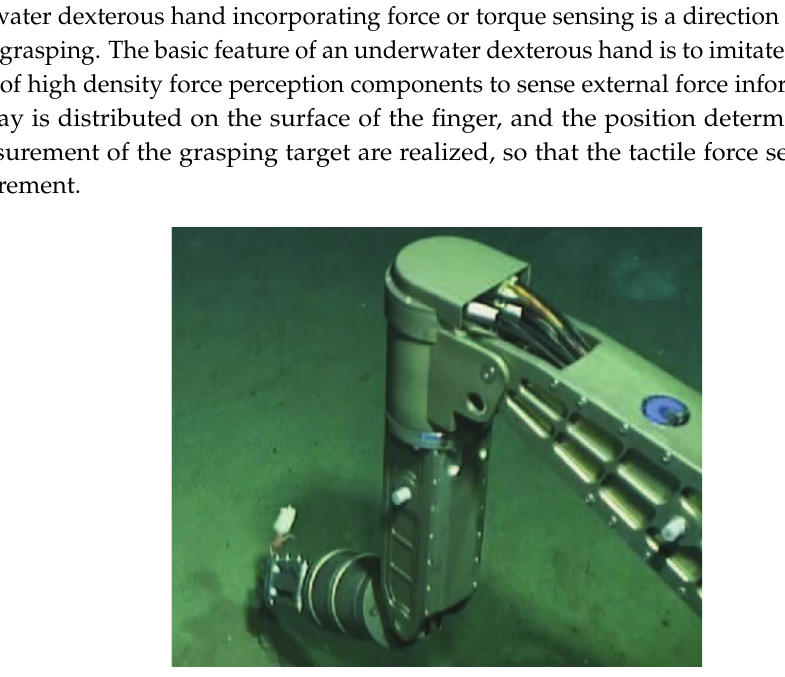
Figure 1. The task diagram of underwater manipulator without force